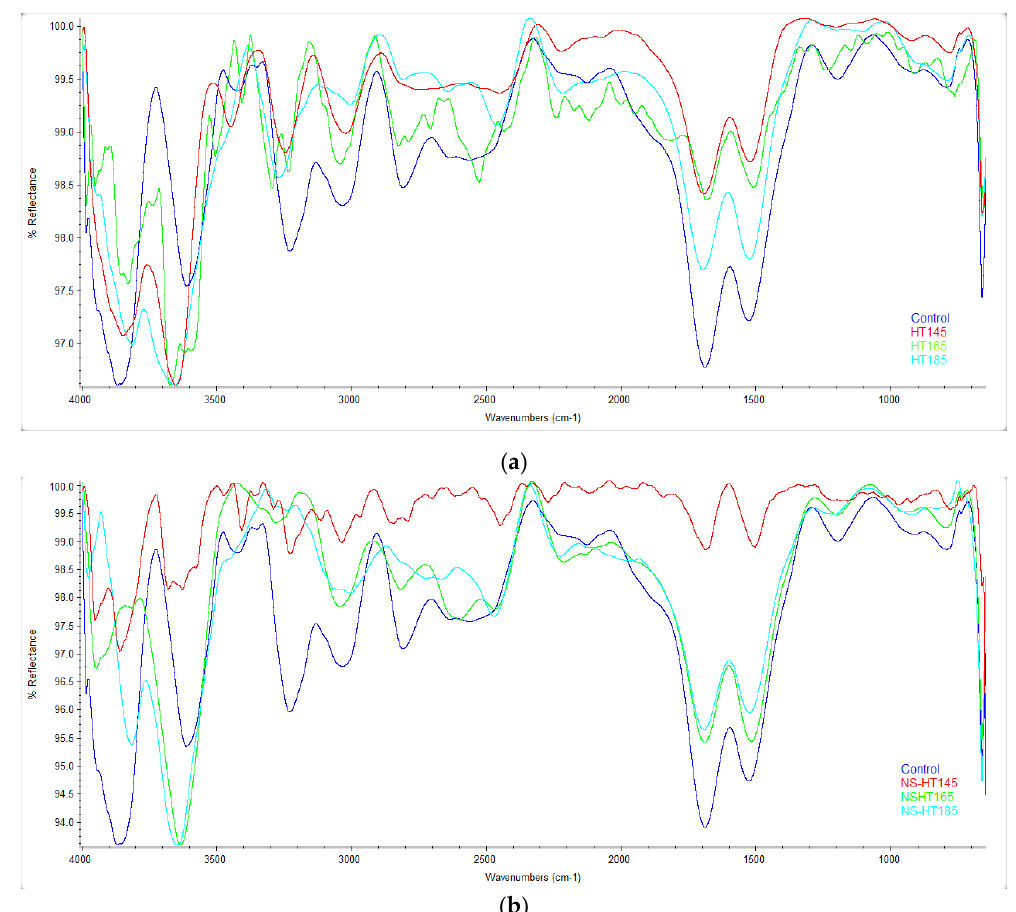
Figure 3. Infrared spectra of control and heat ‐ treated ( a ) and control and NS ‐ impregnated Figure3. Infraredspectraofcontrolandheat-treated( a )andcontrolandNS-impregnatedheat-treated( b ) heat ‐ treated ( b ) Scots pine specimens (HT = Heat ‐ treated; NS = nano ‐ silver impregnated). Scots pine specimens (HT = Heat-treated; NS = nano-silver